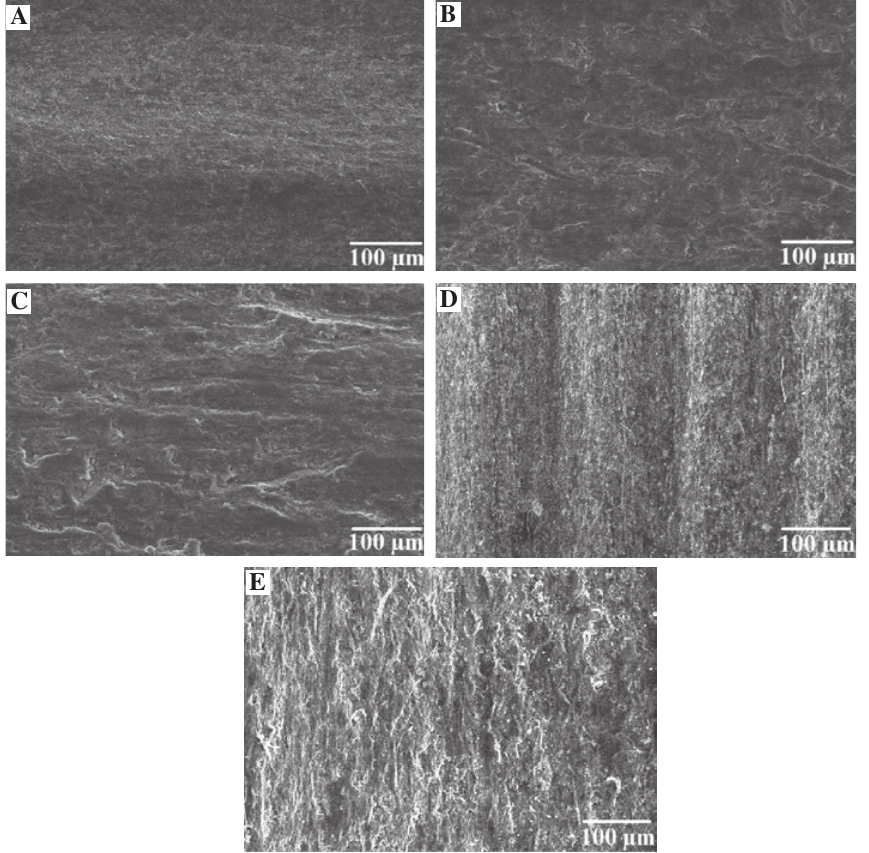
Figure 11: SEM micrographs of (A) outer FGM – 33 N (B) outer FGM – 57 N (C) outer FGM – 80 N (D) homogeneous composite at 80 N and (E) unreinforced alloy at 80